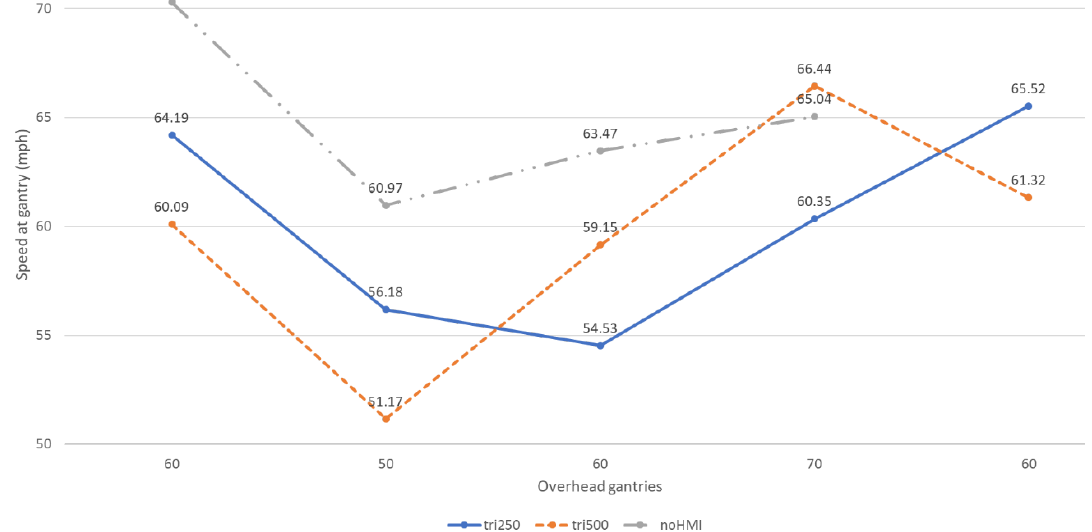
Figure 9 . Graphical representation of the speed (mph) at each overhand gantry in the noHMI condition and both experimental conditions. Blue plain line represents the trig250 m (n = 10) condition, the orange dashed line the trig500 m condition (n = 10), and the grey mix plain-dashed line the noHMI condition (n = 20).